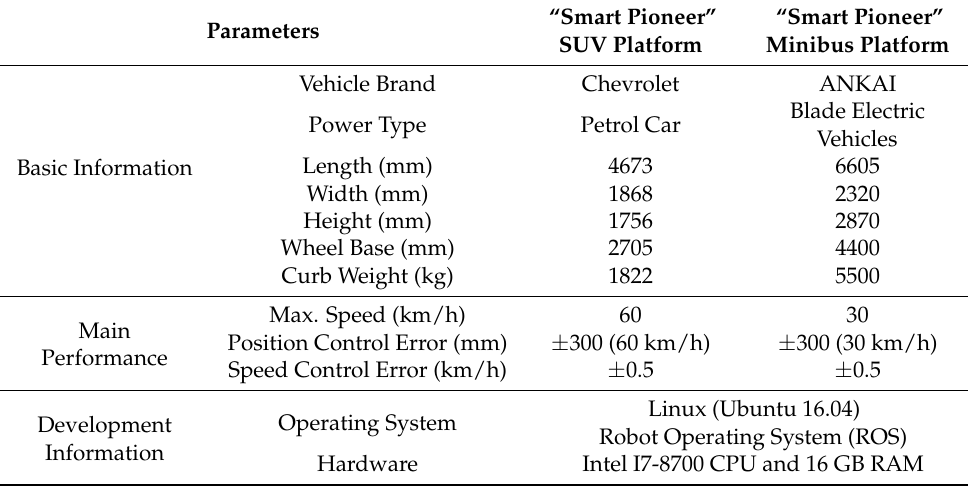
Figure 23. The experimental platform of "Smart Pioneer": ( a ) The "Smart Pioneer" SUV platform, equipped with a Robosense Ruby 128-line 3D LiDAR and GPS receiver in the middle of the roof. ( b ) The "Smart Pioneer" Minibus platform. The four corners are equipped with four Beike Tianhui R-Fans 16-line 3D LiDAR. A SICK LD-MRS 8-line 3D LiDAR is also mounted on the front, and the GPS receiver is equipped on the top of the car. Table 5. The parameters of the "Smart Pioneer" experimental